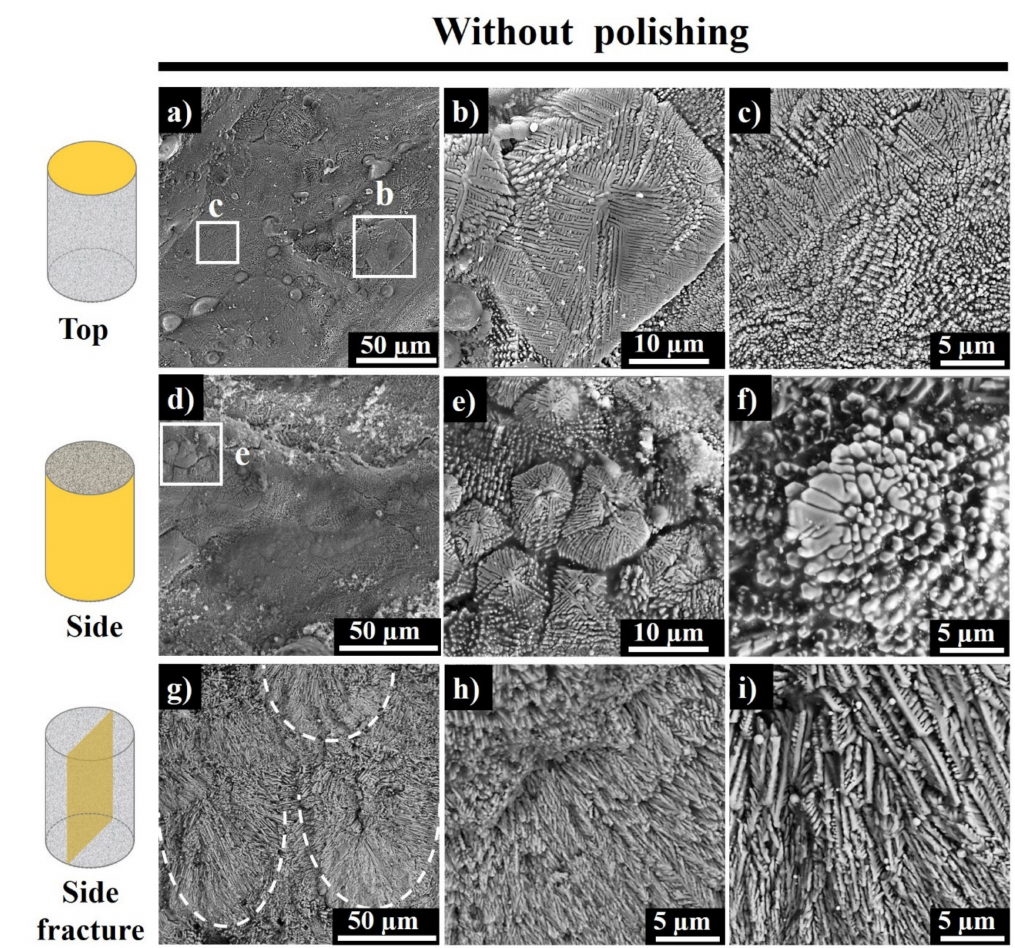
Figure 7. Top ( a – c ) and side ( d – f ) surface SEM images of as-built sample E9 and SEM images of unpolished side fracture ( g – i ) of E9 (white dashed ovals show the melt